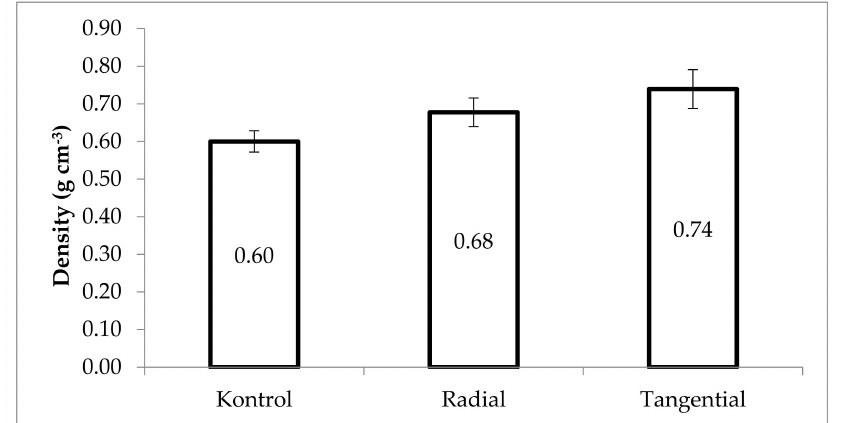
Figure 3. The Density of Pine Wood from Radial Board and Tangential